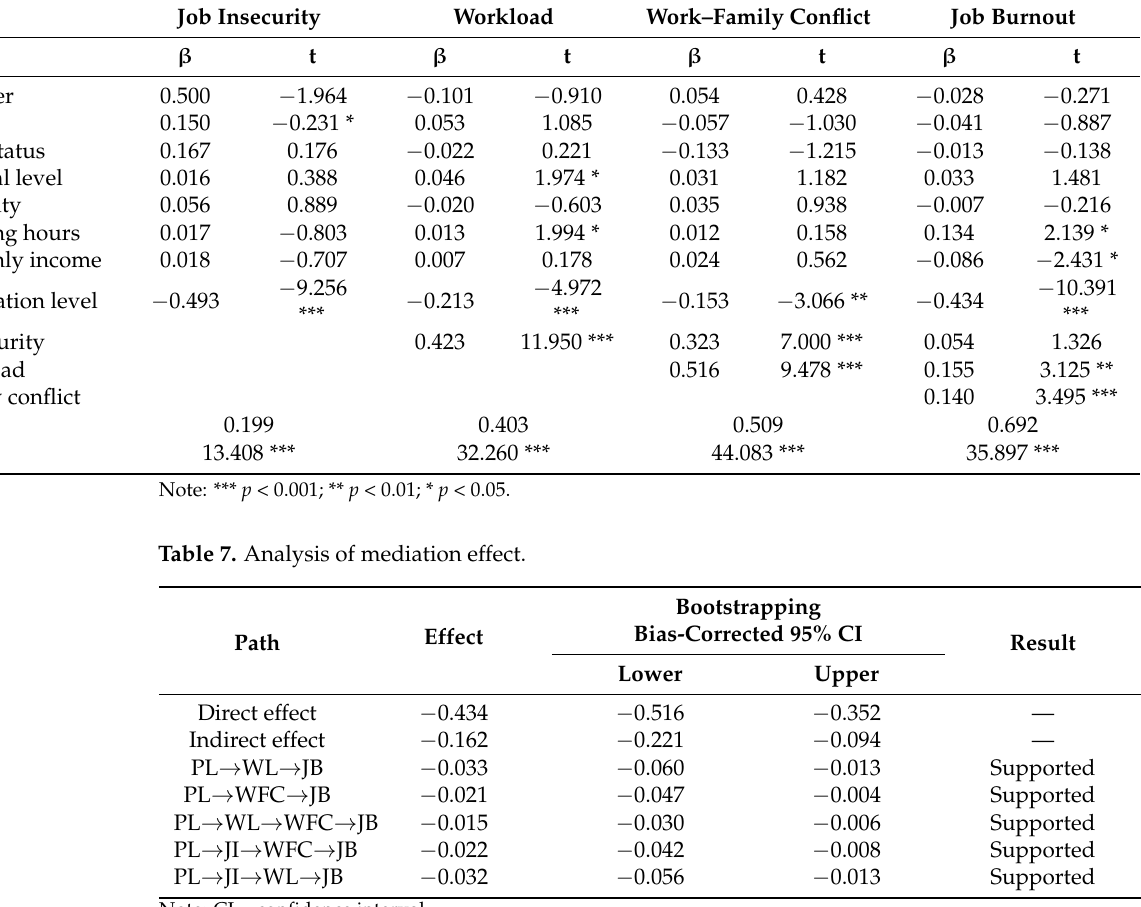
Table 6. Results of regression analysis. (N = 441).